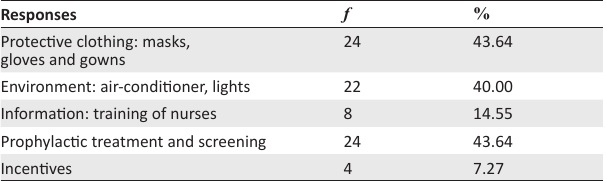
TABLE 12: Respondents’ views on measures that government should put in place to protect community nurses ( n =